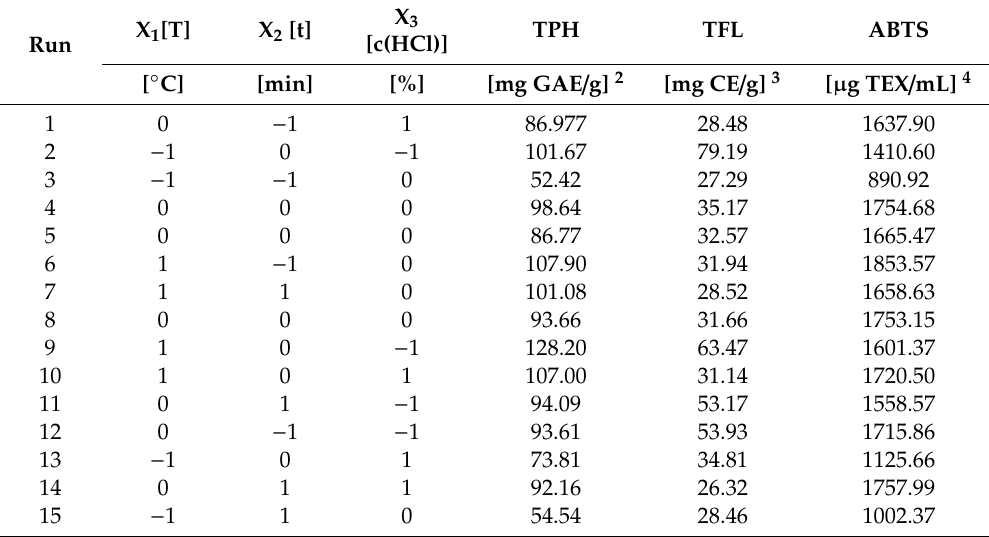
Table 2. Content of total phenols (TPH), total flavonoids (TFL), and antioxidant activity (expressed as ABTS 1